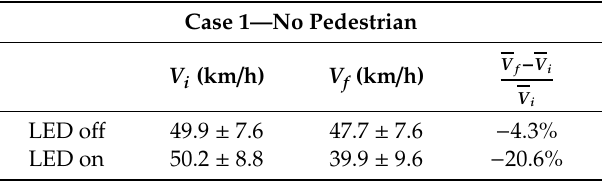
Table 1. Mean speed comparison (no pedestrian).